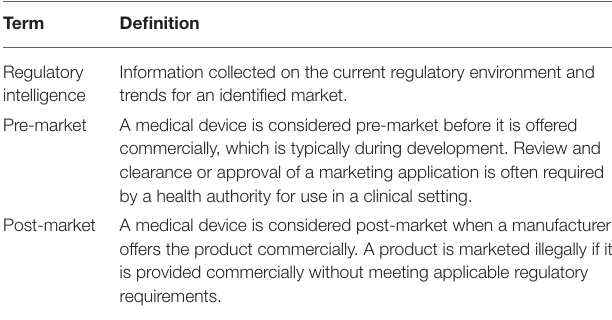
TABLE 1 | Terminology defined: market environments.